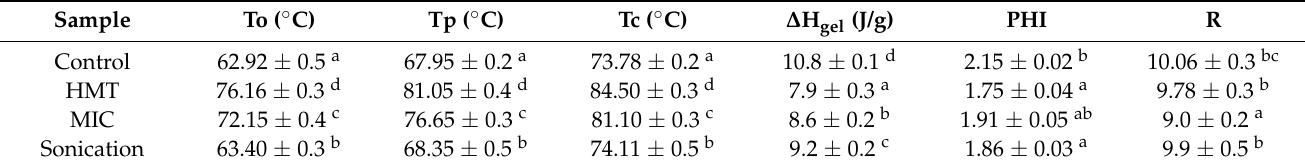
Table 2. Thermal properties of native and modified starches.